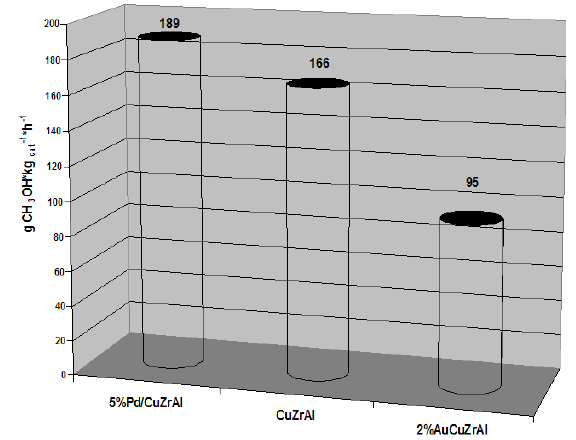
Figure 5. Catalytic activity for ternary CuZrAl and promoted by Pd and Au ternary catalysts at 260°C under 4.8